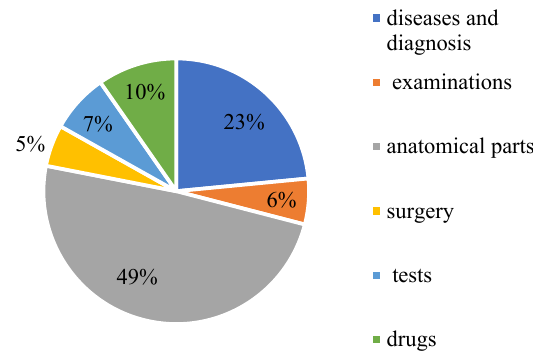
Figure 10. The proportion of medical entities on CCKS2019.